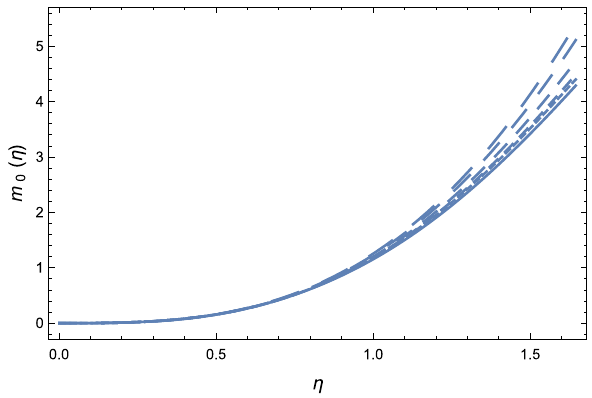
Fig. 2 Variation of the dimensionless mass profile m 0 (η) as a func- tion of the dimensional radial coordinate η of a collapsing rotating Bose–Einstein condensate dark matter halo for different values of the parameter γ 0 : static case with γ 0 = 0, (solid curve), and dynami- cal evolution with γ 0 = 0 (dotted curve), γ 0 = 0 . 25 (short dashed curve), γ 0 = 0 . 50 (dashed curve), γ 0 = 0 . 75 (long dashed curve), and γ = 0 . 90 (long dashed curve), respectively. To numerically integrate 0 the system of equations (136) and (137) we have used the initial con- (η ) = ( 12 /π)η 2 ditions m 0 (η 0 ) = ( 4 /π)η 3 and u (η 0 ) = m (cid:12) , with 0 0 0 0 = 10 − η 0